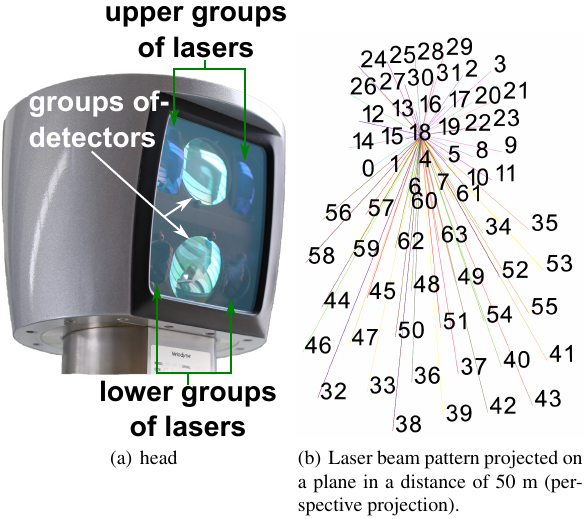
Figure 2: Velodyne HDL-64E